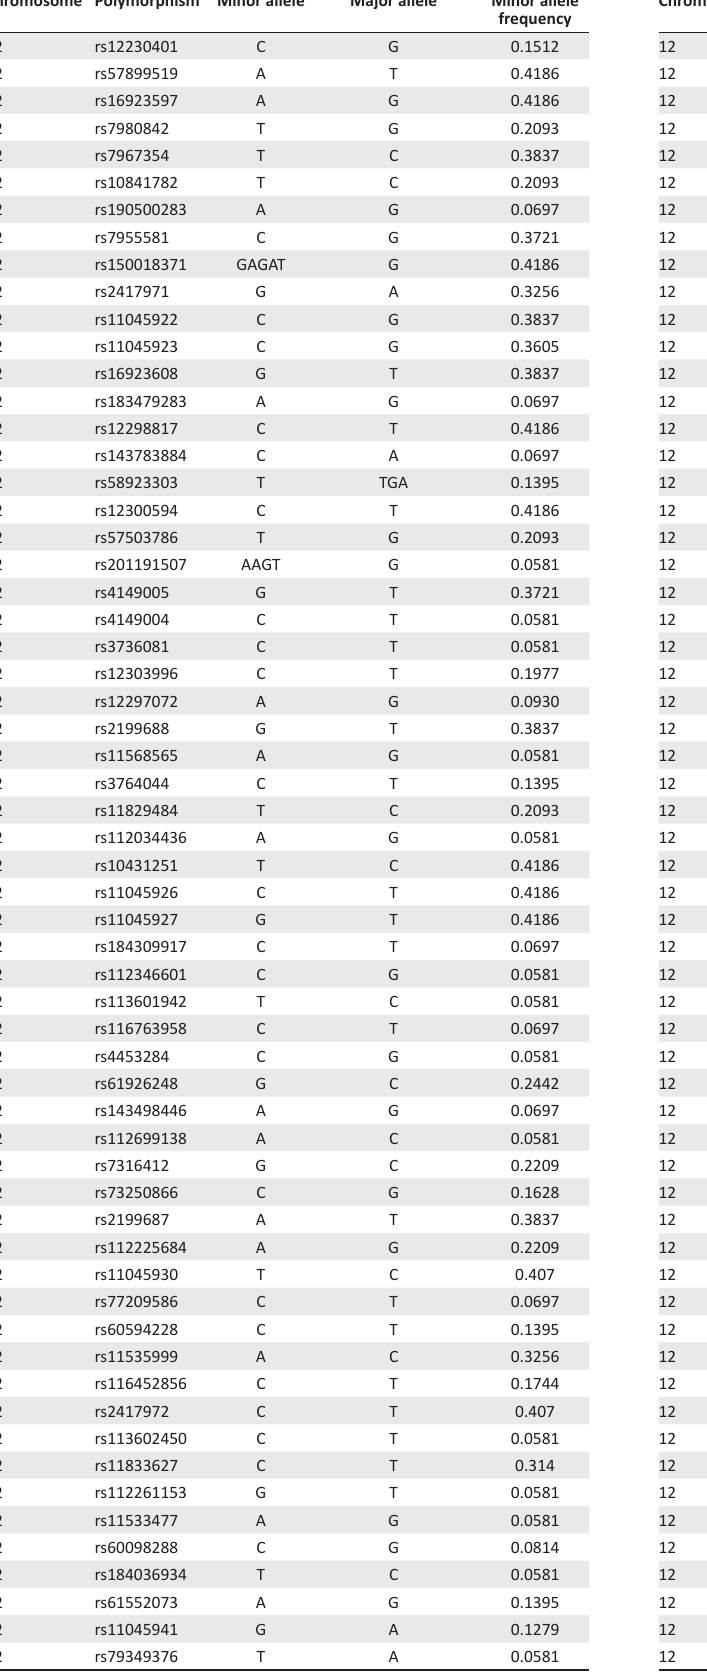
Table 1-A1 continues on the next page →Table 1-A1 continues in the next column